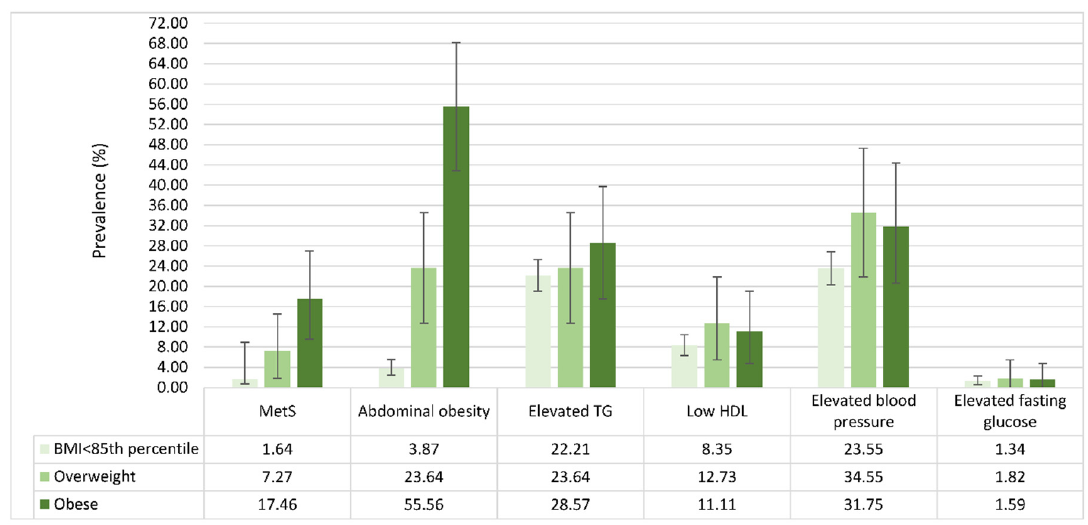
Figure 2. Prevalence of paediatric MetS and its components by body mass index (BMI) category. Table 3. Logistic regression analysis of the correlates associated with paediatric MetS.